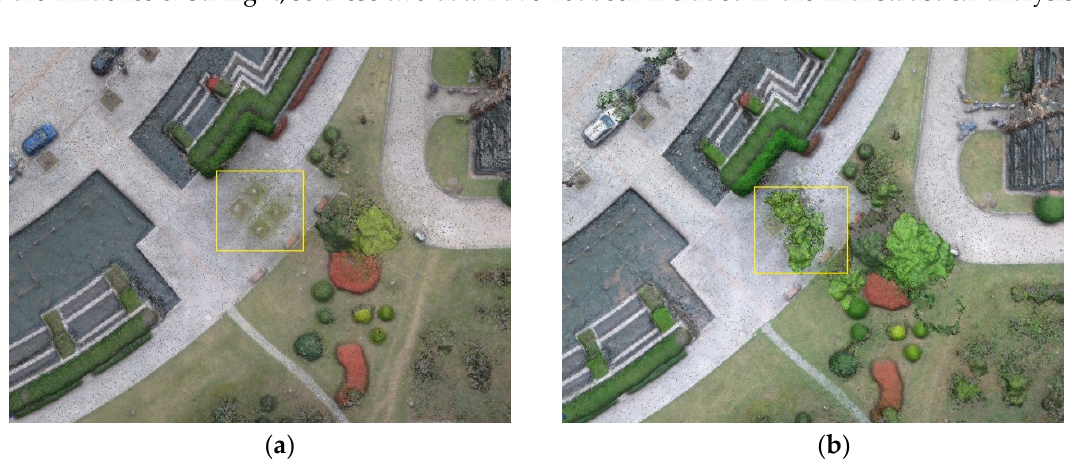
Figure 11. The 3D point cloud model of the single plant on 2 April ( a ) and 25 April 2019 ( b ). Table 5. Changes of the canopy area and weather situation of the single plant from 2 April to 1 May 2019.